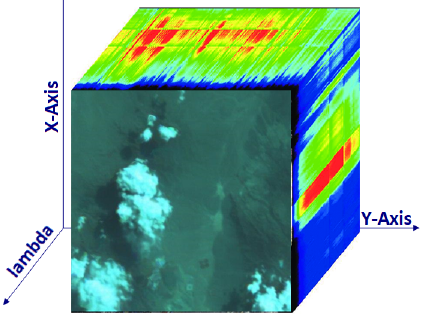
Figure 1. Example of hyperspectral